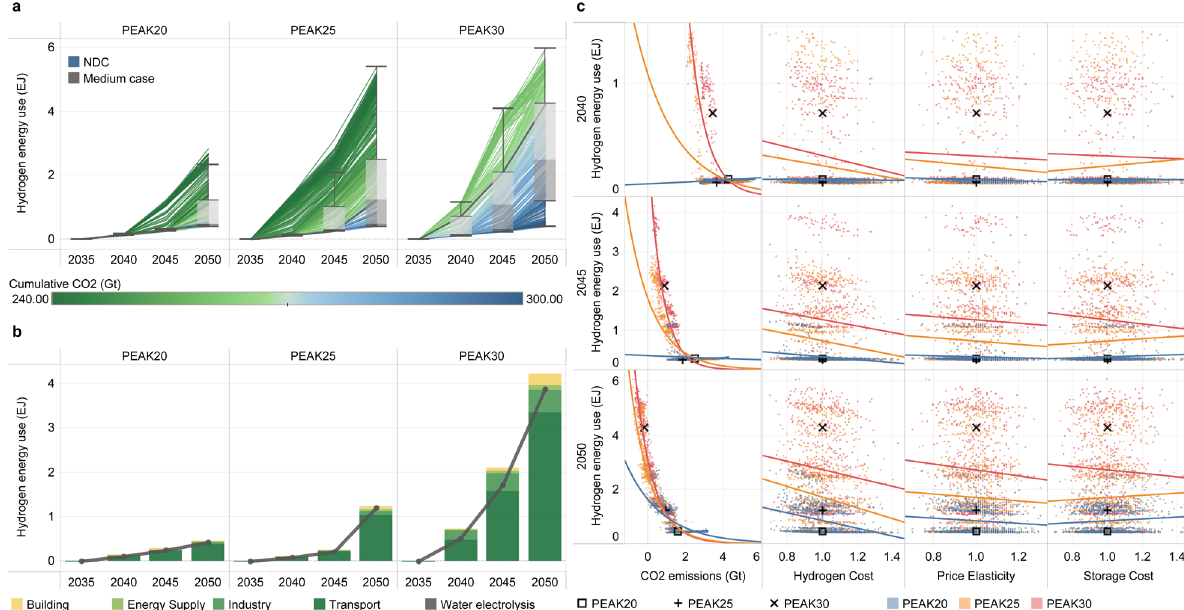
Fig. 7 Uncertainty analysis of hydrogen energy. a shows the development of hydrogen energy (unit: EJ). The box plot shows the fi rst quantile, intermediate range (IQR), and third quantile of all the results, where the data range within 1.5 times the IQR is denoted with whiskers. The thick blue line represents the pathway of the NDC scenario, and the thick gray line represents the pathway for the intermediate case in each scenario. The divergent color from blue to green re fl ects the increasing stringency of the cumulative carbon budget. The cumulative CO 2 parameter corresponds to the absolute value of China ’ s cumulative carbon budget for 2010 – 2050. b presents a decomposition of the different uses of hydrogen energy (stacked bar chart) and the production of hydrogen from water electrolysis (black line) for the intermediate cases. c represents the relationship between the development of the hydrogen energy and uncertain input parameters and CO 2 emissions. Three parameters with signi fi cant impacts among the fourteen uncertain input parameters are shown for each technology. The remaining results are shown in Supplementary Fig. 12. The variables (except for the CO 2 emissions) represent multiples of the intermediate cases for each scenario. The intermediate cases of PEAK20, PEAK25, and PEAK30 are denoted with square, plus, and multiplication signs,